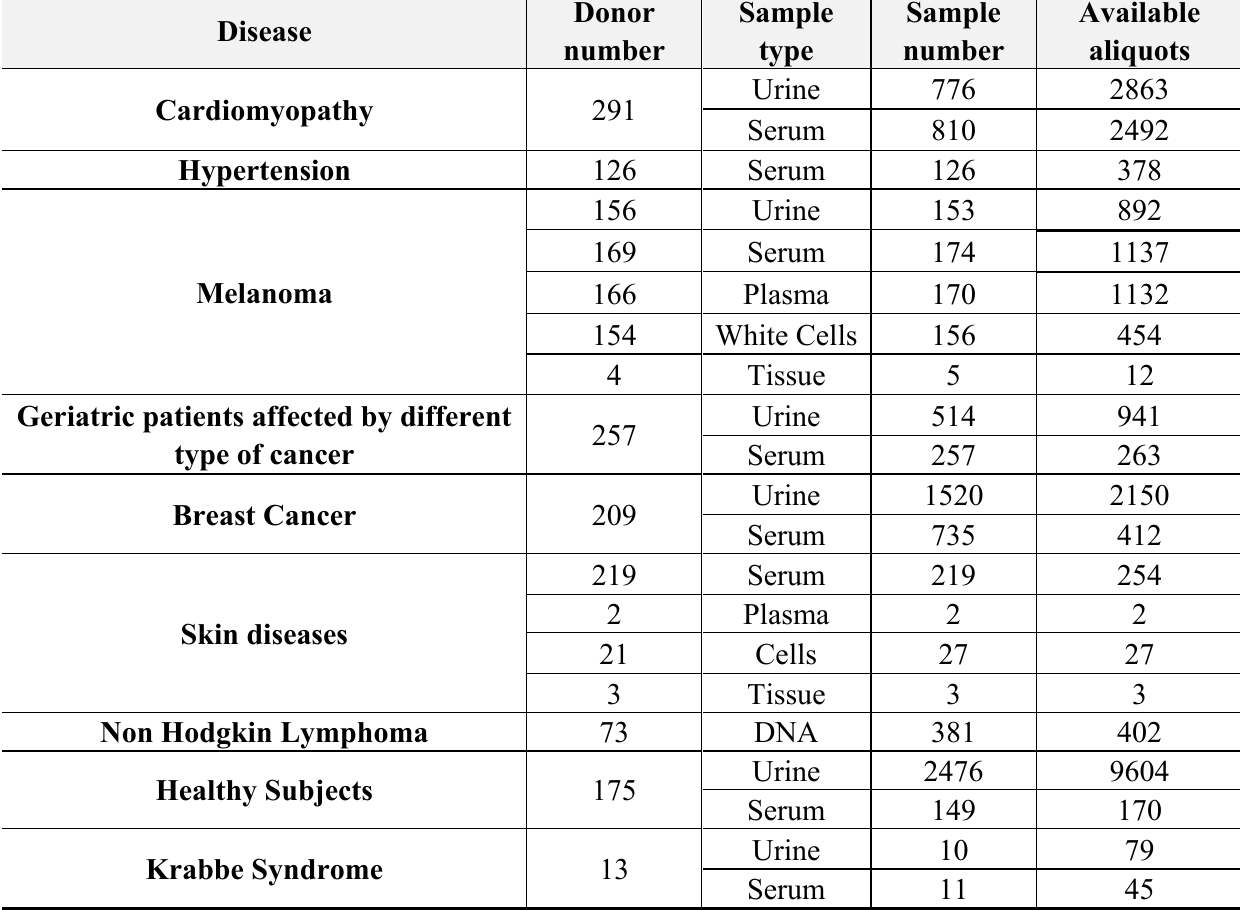
Table A1. The different kind of biosamples available for each disease, as absolute numbers.